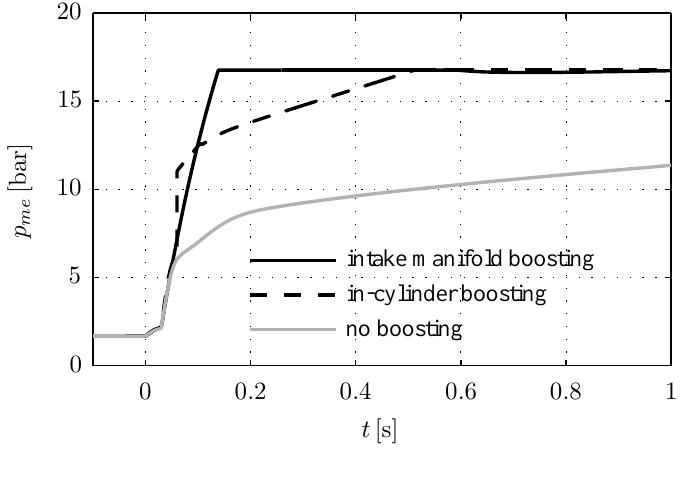
Figure 9. Simulated p trajectories for intake manifold boosting and in-cylinder boosting me for a load step from 1.7 bar to 16.7 bar p at 2000 me